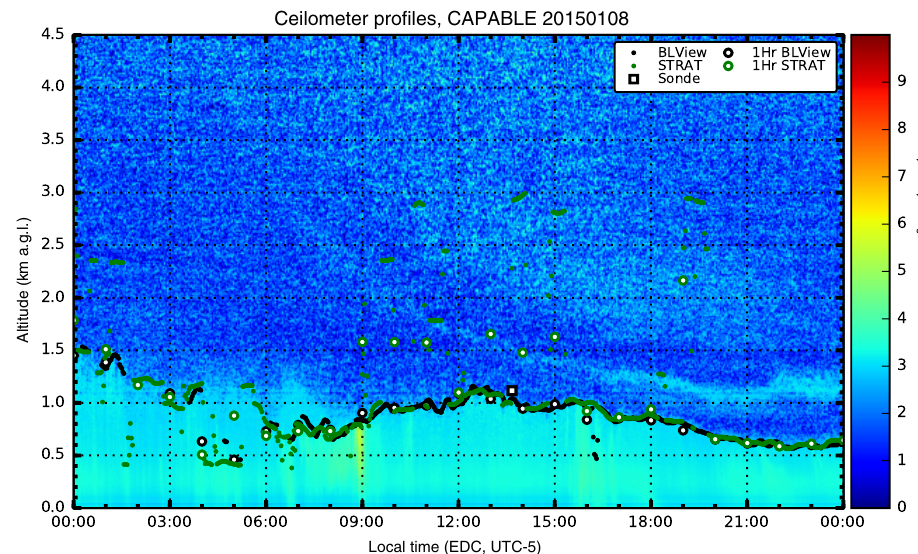
Figure 11. Example plot in which STRAT fails to identify a reasonable MLH due to unusually clean